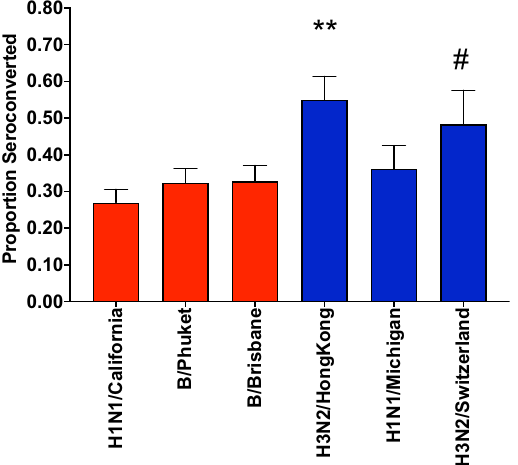
Fig. 1 Proportion of subjects that seroconverted ( ≥ 4-fold rise in Ab titre from D0). Data displayed as proportion ± standard error of fi t. Red bars: recurring strains (present in vaccine ≥ 2 seasons), blue bars: novel strains in vaccine season. **signi fi cant difference ( p < 0.001) to all recurring strains (H1N1/California, B/Phuket & B/ Brisbane), # signi fi cant difference ( p < 0.05) to recurring strain H1N1/California only. Signi fi cance between proportions calculated by Yates ’ Chi-square test.